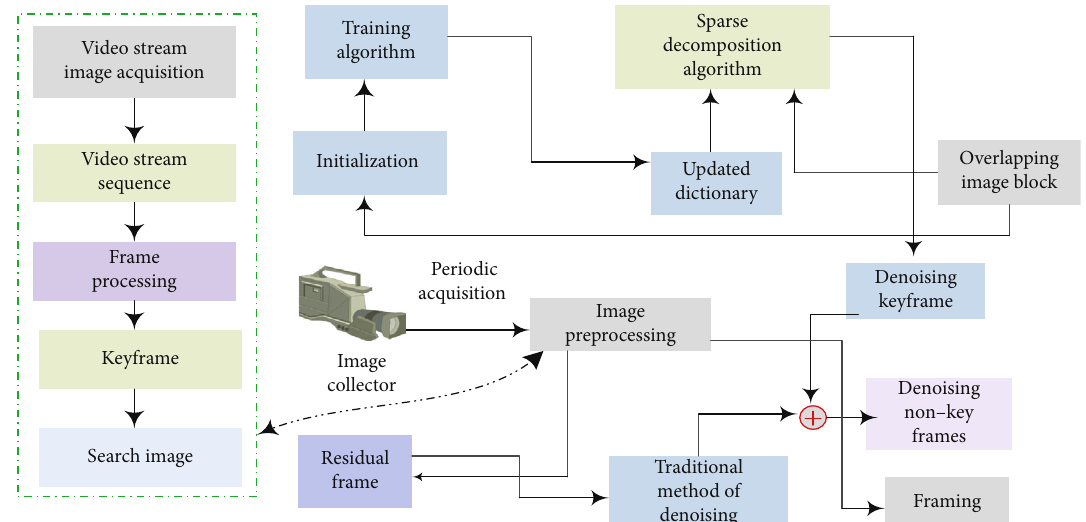
Figure 1: Cognitive processes and emotional thinking development patterns in vocal singing.